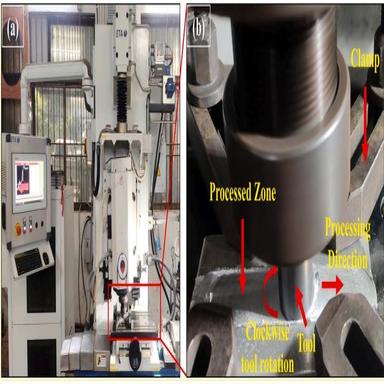
(a) FSP machine (b) Experimental setup of processing area.